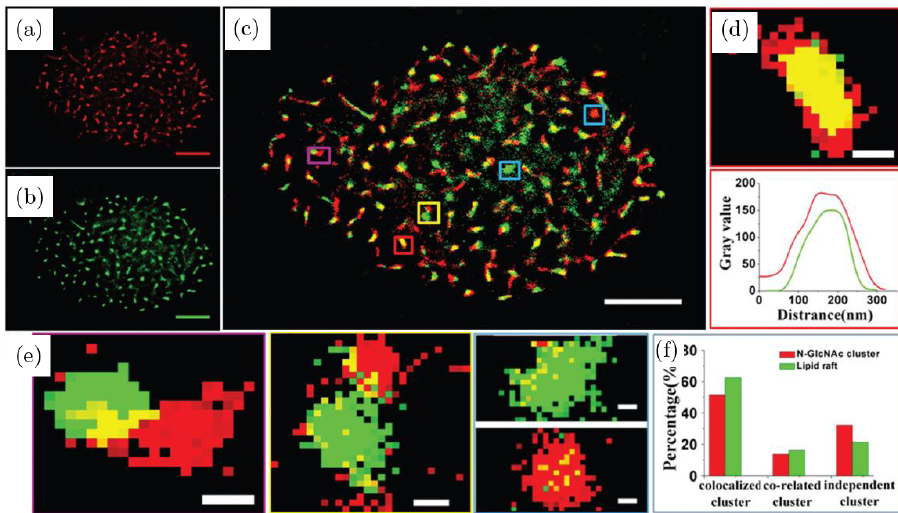
Fig. 10. Dual-color dSTORM imaging of GlcNAc clusters and lipid-raft domains on the Vero apical membranes. [(a) and (b)] dSTORM images of GlcNAcs and lipid rafts on the representative Vero apical surface, by being labeled with Alexa647-linked WGA and lipid raft marker, respectively. (c) Composite graph of (a) and (b), showing that two types of molecules are mostly co-localized. (d-up) Magni¯ed image of the red box region in (c), displaying a typical co-localized relationship of two domains, which further illustrated by the corresponding intensity pro¯les of two domains (d-below). (e) Enlarged images of boxed regions in (c) classify three types of positional relationships: the co-localized domains (left), the related domains (middle), and the independent domains (right). (f) Histogram of three types of domains from 10 cells in three independent experiments. Scale bars are 5 (cid:1) m in (a) – (c), and 200 nm in (d) and (e). Adapted with permission from Ref.